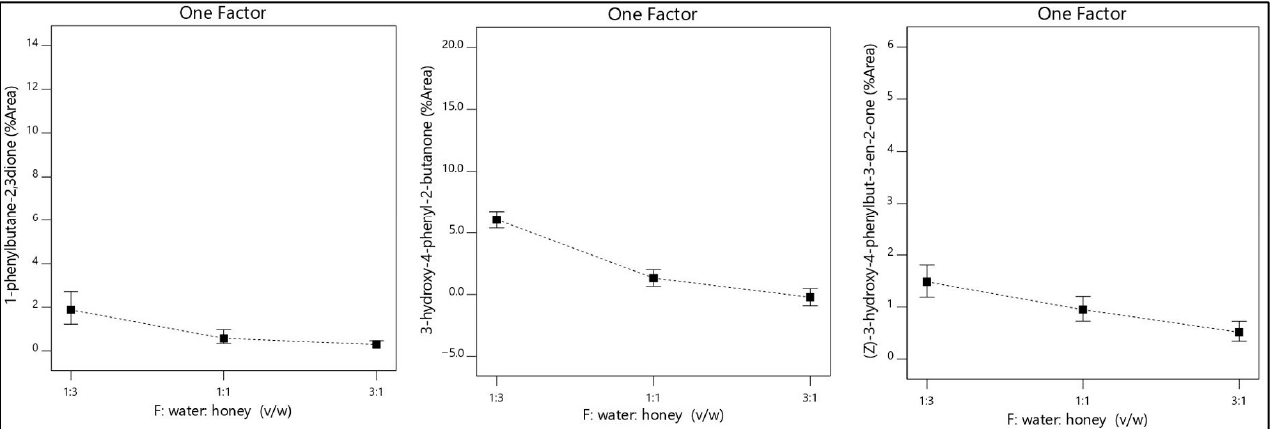
Figure 4. The ratio of water: honey ( v / w ) effect in the isolation of 1-phenylbutane-2,3-dione, 3-hydroxy-4-phenyl-2-butanone, and ( Z )-3-hydroxy-4-phenylbut-3-en-2-one.